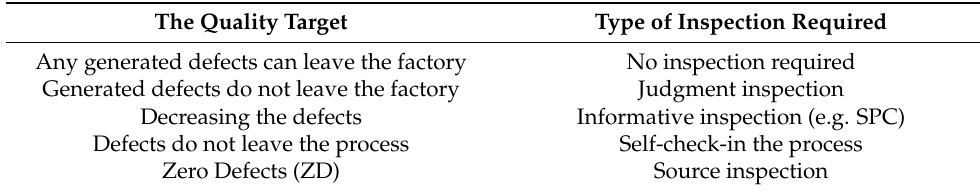
Table 1. The different inspection techniques for each quality level (adapted and modified from (Shimbun, 1989)). The Quality Target Type of Inspection Required Any generated defects can leave the factory No inspection required Generated defects do not leave the factory Judgment inspection Decreasing the defects Informative inspection (e.g. SPC) Defects do not leave the process Self-check-in the process Zero Defects (ZD) Source